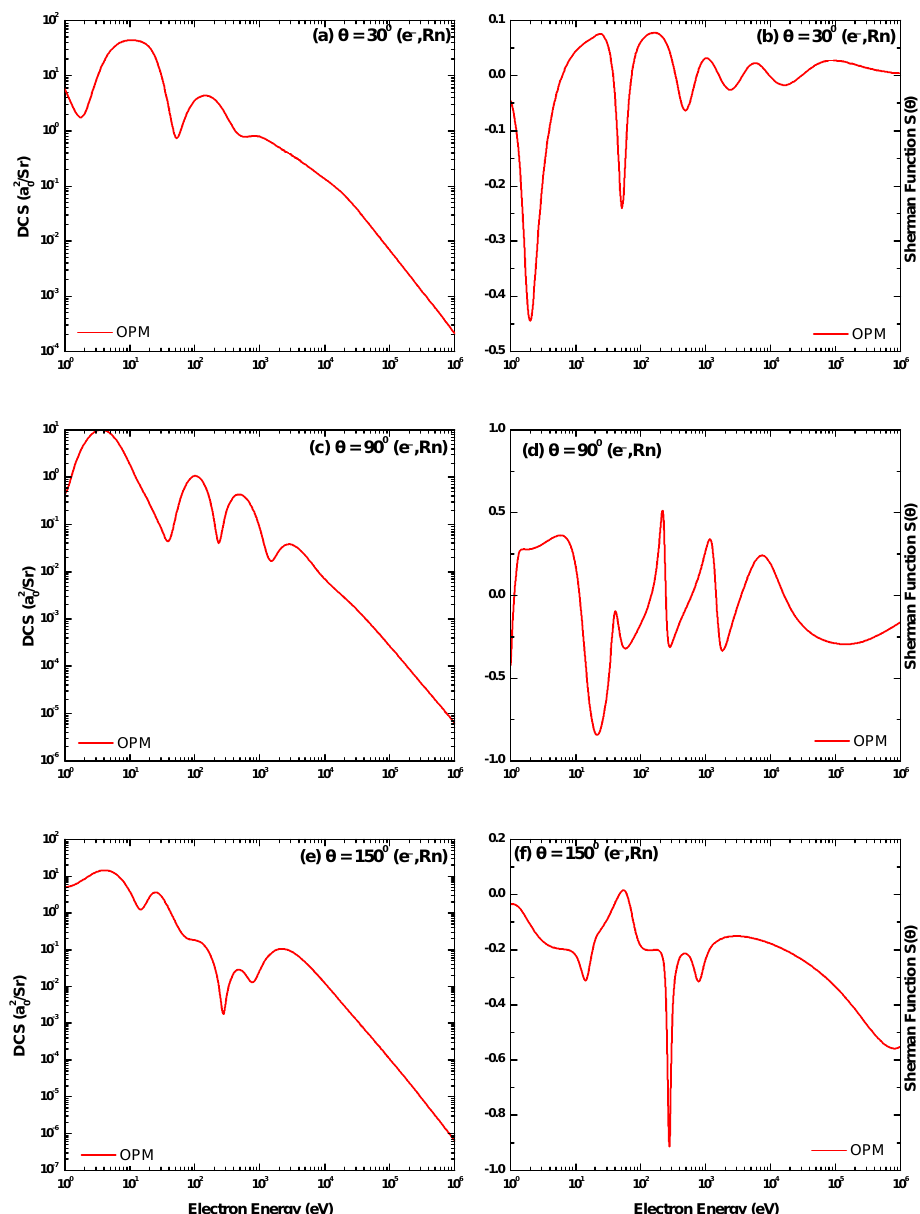
Figure 13. Energy dependence of the DCS and the Sherman function for elastic scattering of electrons from neutral radon atoms at scattering angles ( a , b ): 30 ◦ , ( c , d ): 90 ◦ and ( e , f ): 150 ◦ . The energy variation of the corresponding Sherman function (panels b, d and f in Figure 13) shows that the magnitude of | S | increases with the increase of scattering angles θ . The appearance of the structure continues up to more energies at lower scattering angles than at higher one. However, the position of the highest extremum is shifted to higher energies with increasing the scattering angles. All of these features might be explained as the fact that the exchange potential, which significantly affects the minima, has less influence in the backward direction. For high energies, on the other hand, due to the smaller projectile-nucleus distance, the stronger nuclear field has a significant effect on the spin polarization implying that the magnitude of | S | increases with increasing scattering